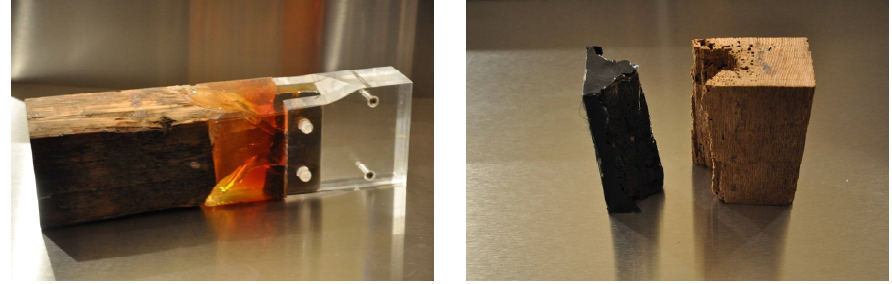
Figure 6: Experimental Repairs.